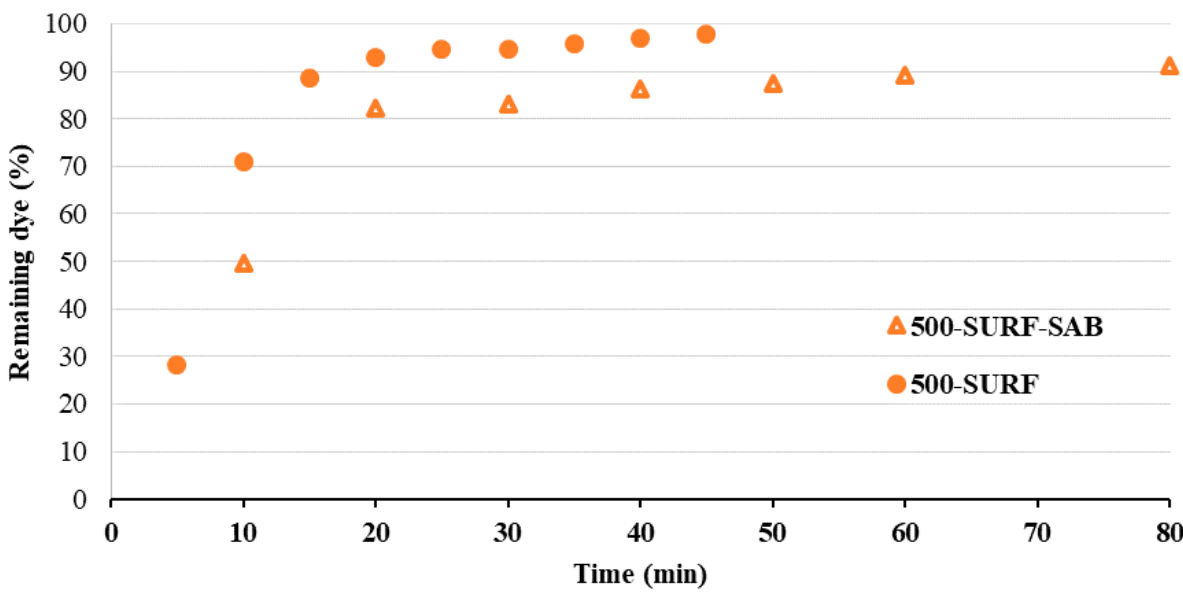
Figure 8. AZ and MO remaining dye (%) for solutions flowed through the membrane 500-SURF under the pressure of 1 bar (the dye initial concentration was 0.01 mM and the effective membrane filtration area was 0.00115 m 2 ).